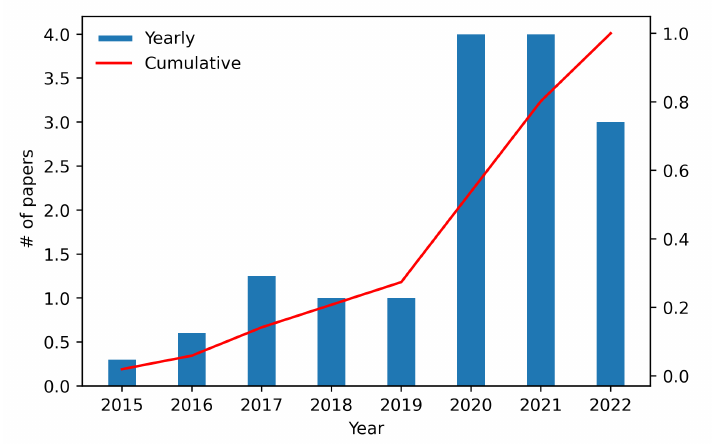
Figure 10. Included papers per year (publishing trend) normalized on monthly base. There was a significant increase in the number of included papers published after